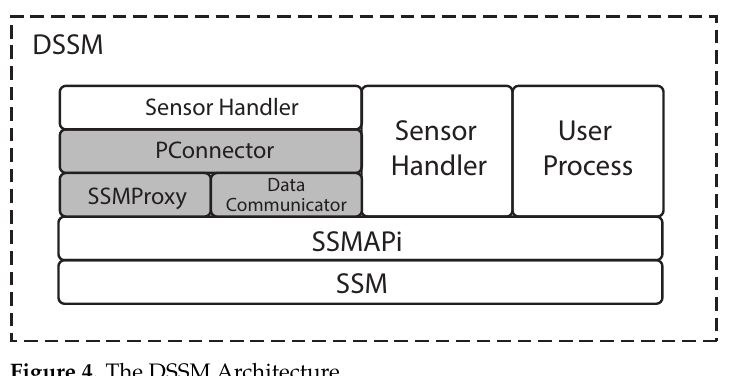
Figure 4. The DSSM Architecture. Table 2. Summary of APIs provided by